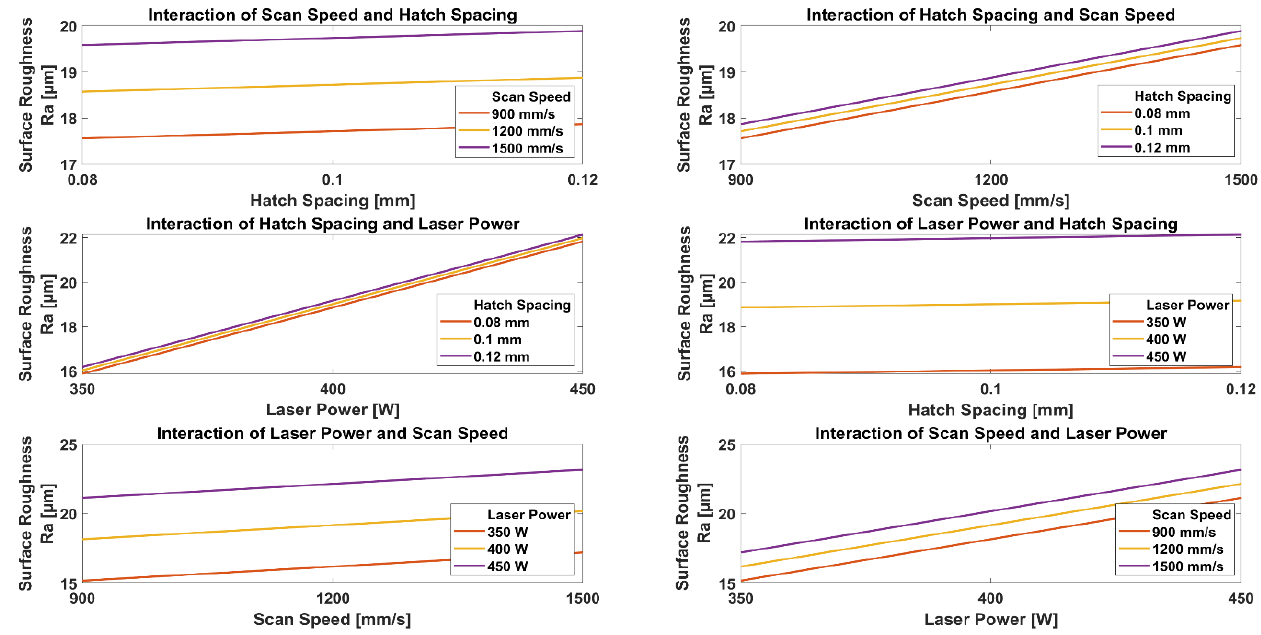
Figure 9. Effects of the interaction of parameters on the measured R a on the top surface.